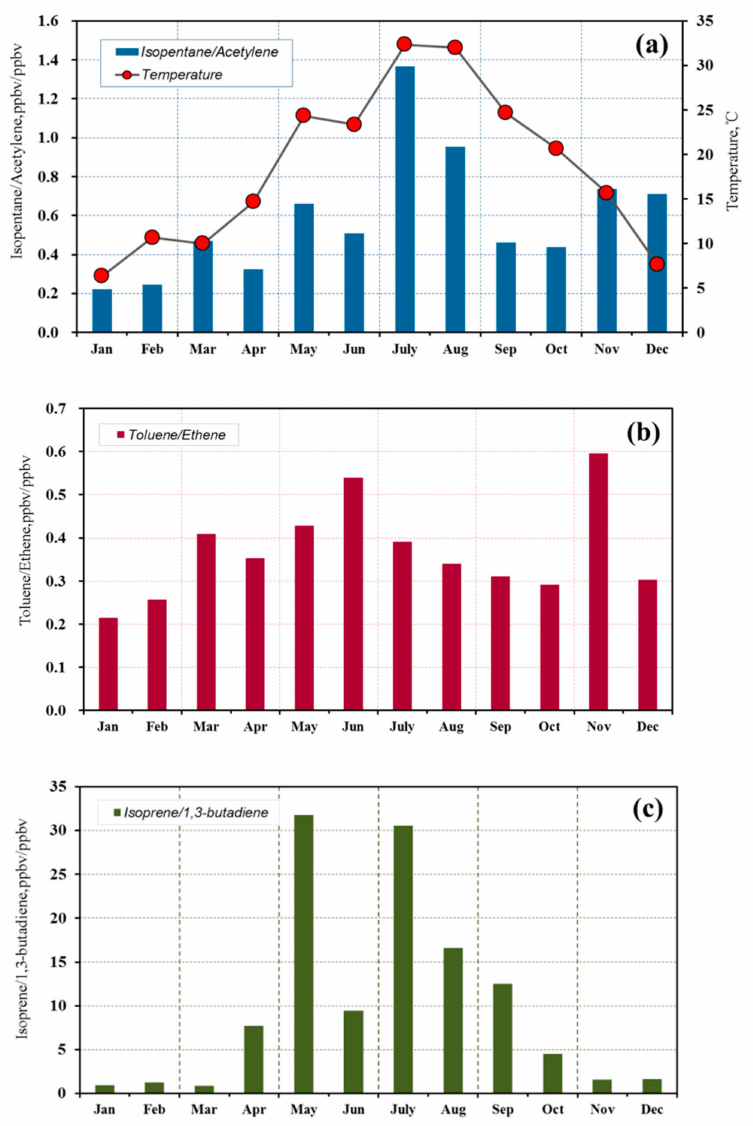
Figure 5. Monthly variations in the average ratios of ( a ) isopentane / acetylene, ( b ) toluene / ethene and ( c ) isoprene / 1,3-butadiene with meteorological elements in Wuhan